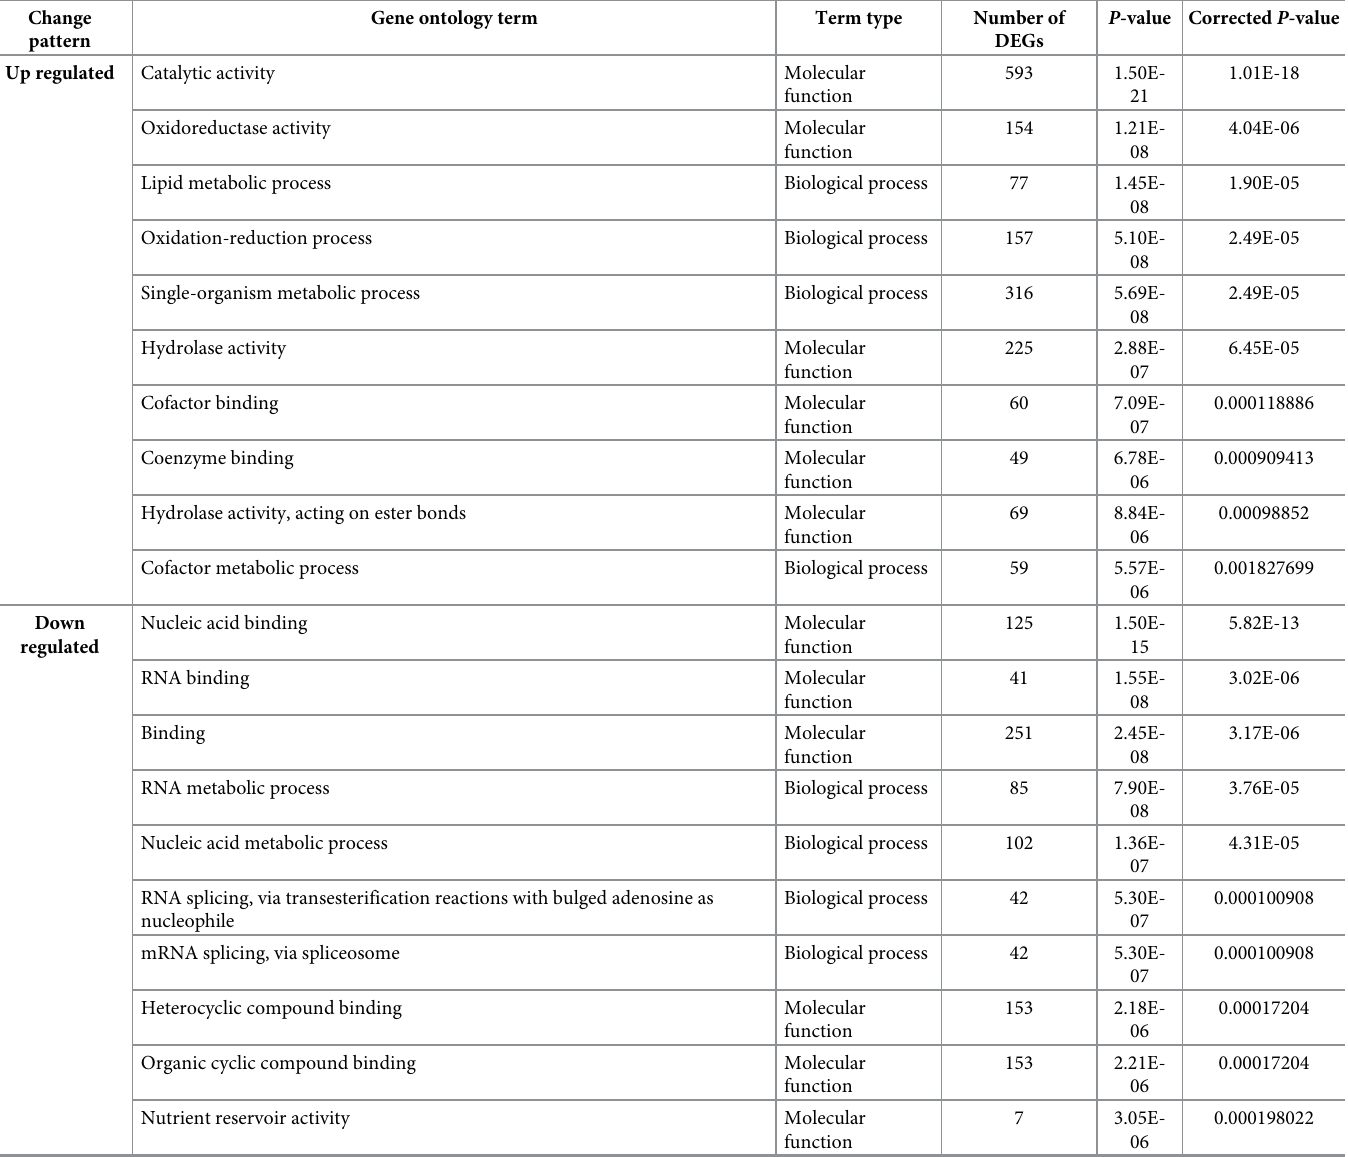
Table 3. Changes identified by GO analysis during T3 to